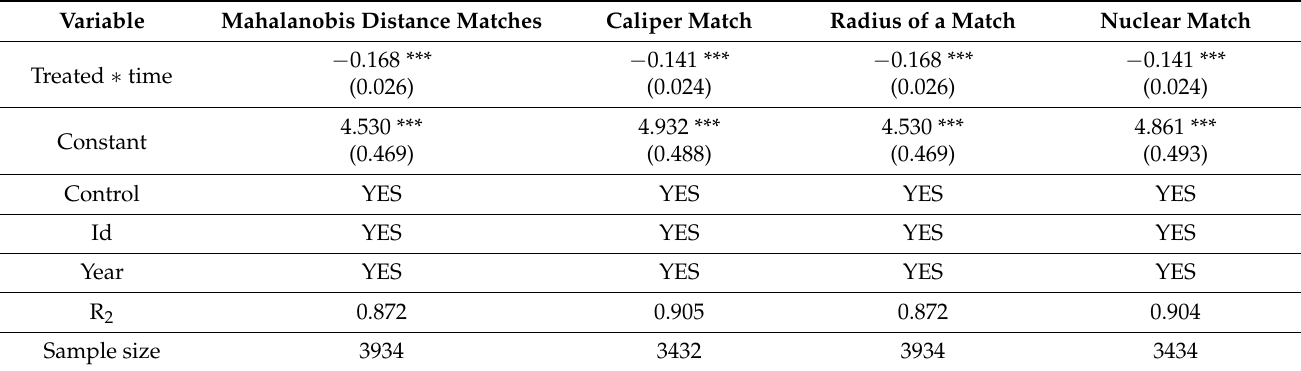
Table 7. Results of replacing the matched